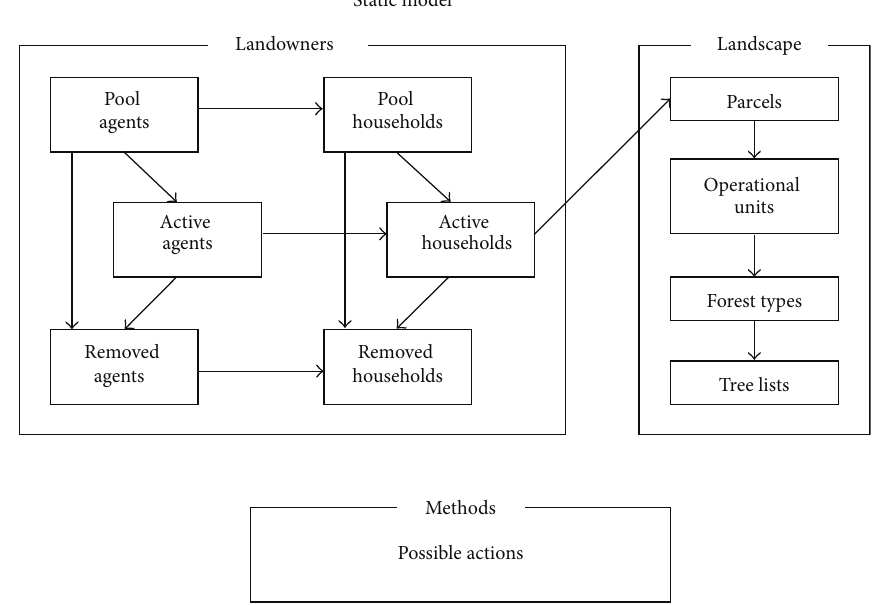
Figure 1: The FLAME static constructs. At any given time period, a pool of agents was associated with households. Active agents and households were those that own land. Inactive agents and households were those either deceased or no longer associated with land. The landscape was broken down by multiple units ranging from parcels to tree lists. Methods included actions available to a given agent, such as light or heavy harvesting.